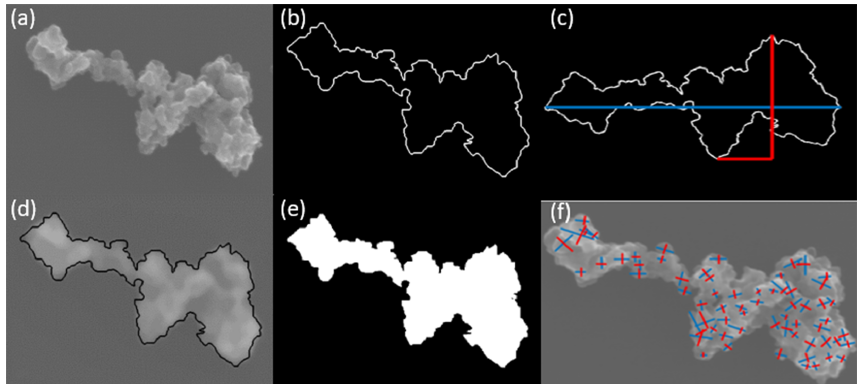
Figure A4. Example of the processing of SEM images. (a) Original image. (b) A manual drawing of an approximate aggregate outline in order to (c) obtain the longest dimension ( L max ) of an aggregate periphery to the perpendicular maximum width ( W max ). (d) Validation of the periphery. (e) Use of the binary figure to obtain project aggregate area ( A a ). (f) Measurement of the primary particle diameter ( d pp